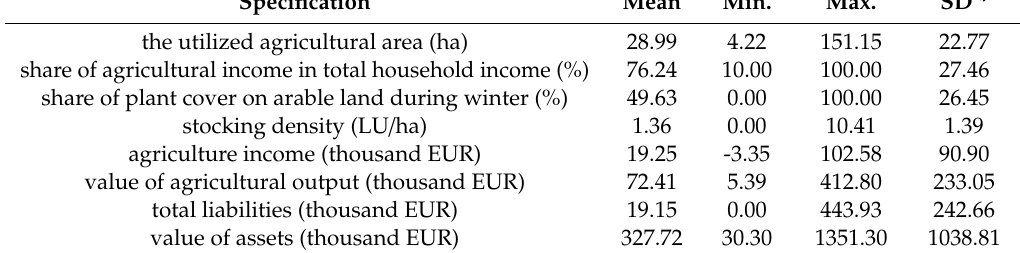
Table 1. Selected descriptive statistics of the farms surveyed in the Wielkopolska region (2018). Specification Mean Min. Max. SD * the utilized agricultural area